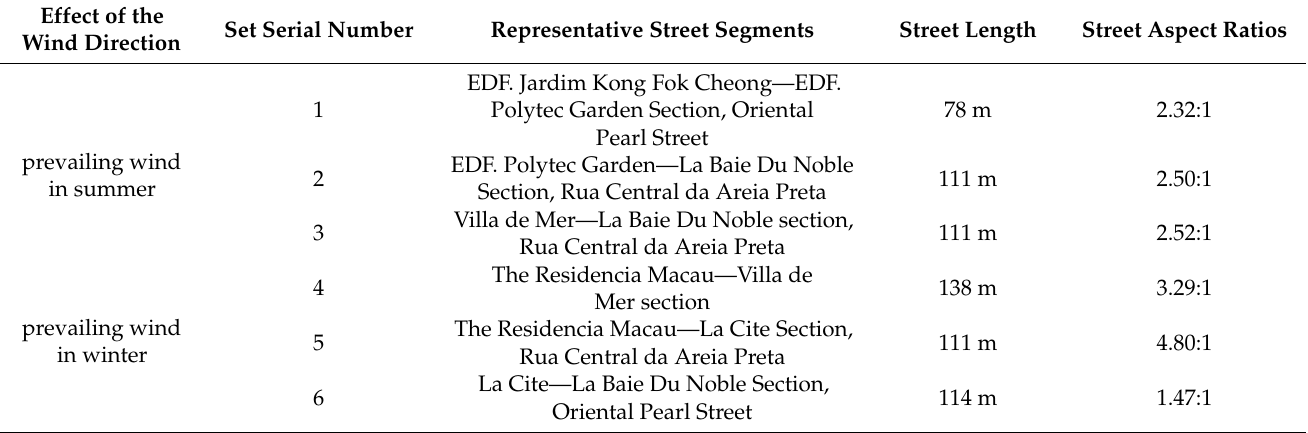
Table 1. The average value of the height-to-width ratio of each street that is greatly affected by